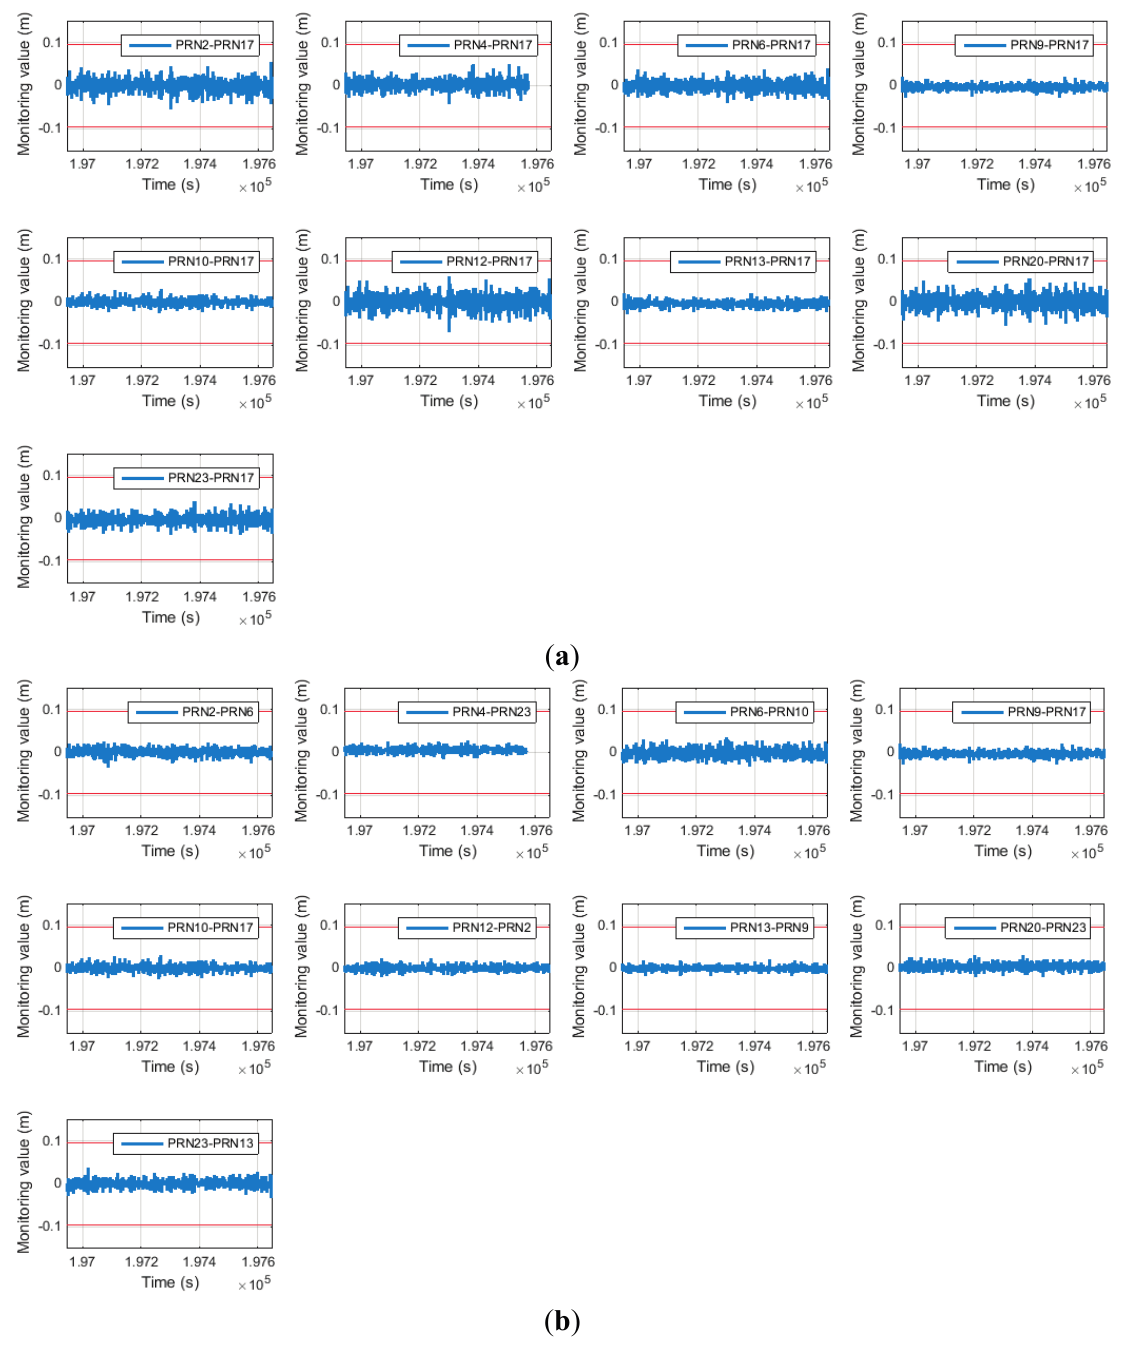
Figure 9. ( a ) Monitoring value error of general SD (above); ( b ) monitoring value error of proposed SD